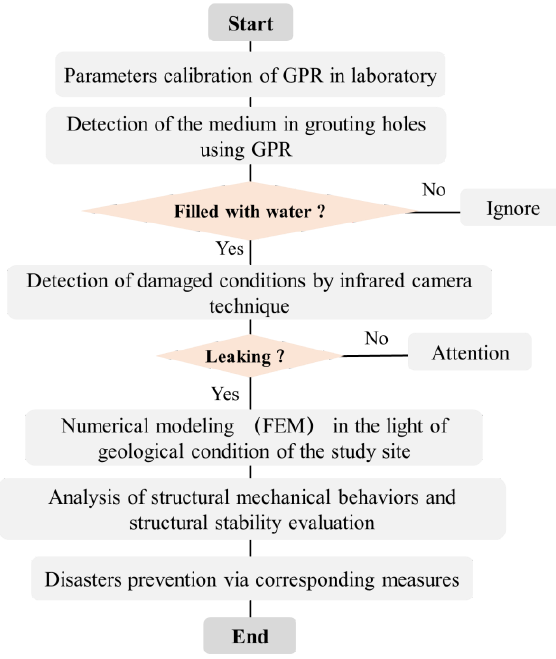
Figure 1. The workflow of the developed methodology.